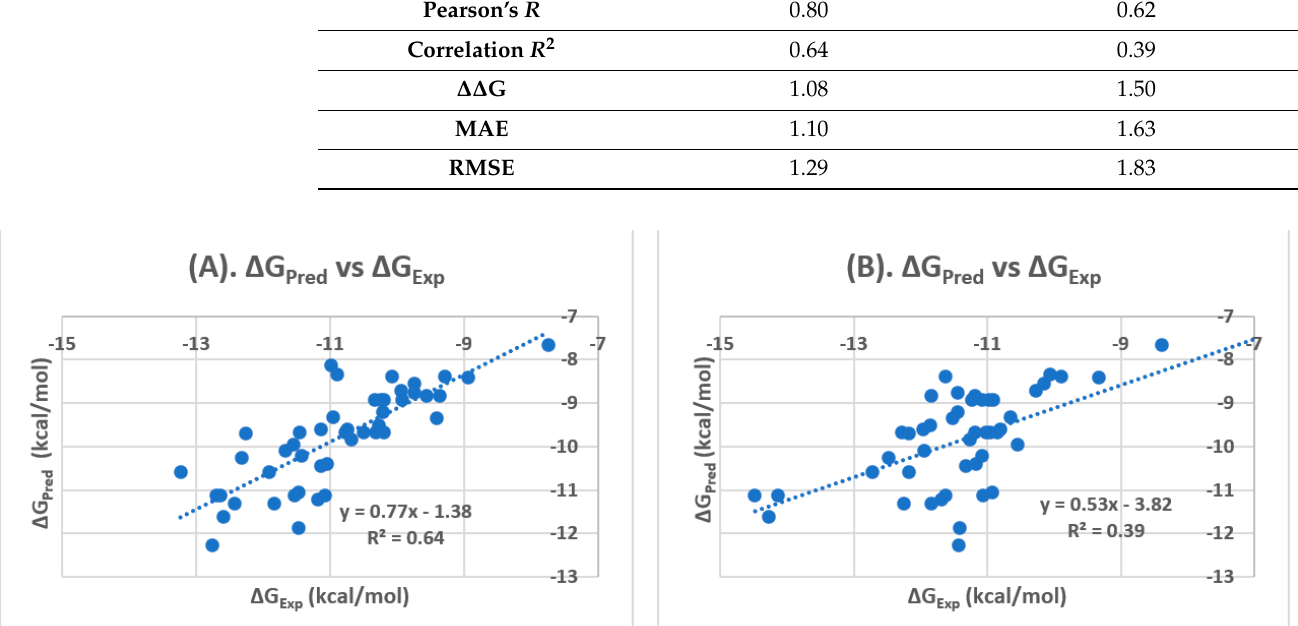
Table 2. Statistical results, the correlation and residual errors between the experimentally obtained ∆ G γ antagonists against the allosteric and orthosteric EXP and the glide scores for the 47 PPAR binding site. Allosteric Binding Site Orthosteric Binding Site